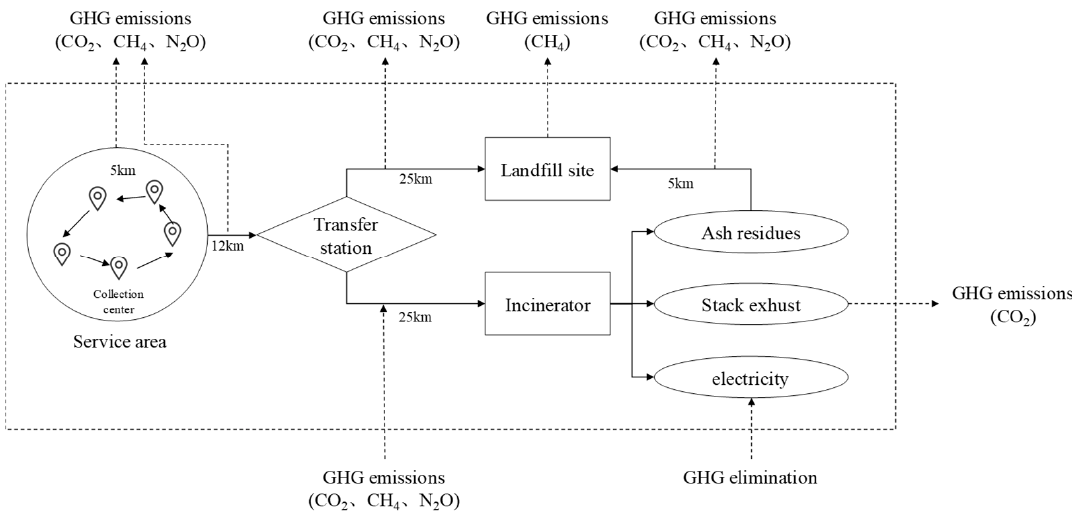
Figure 2. GHG emissions evaluation boundary in Scenario 1.